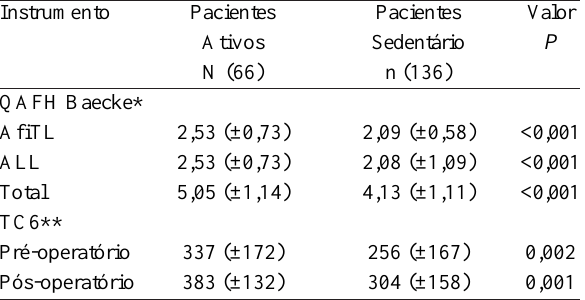
Tabela 4. Característica dos pacientes ativos e sedentários em relação aos escores dos instrumentos de avaliação da atividade física e capacidade funcional.#